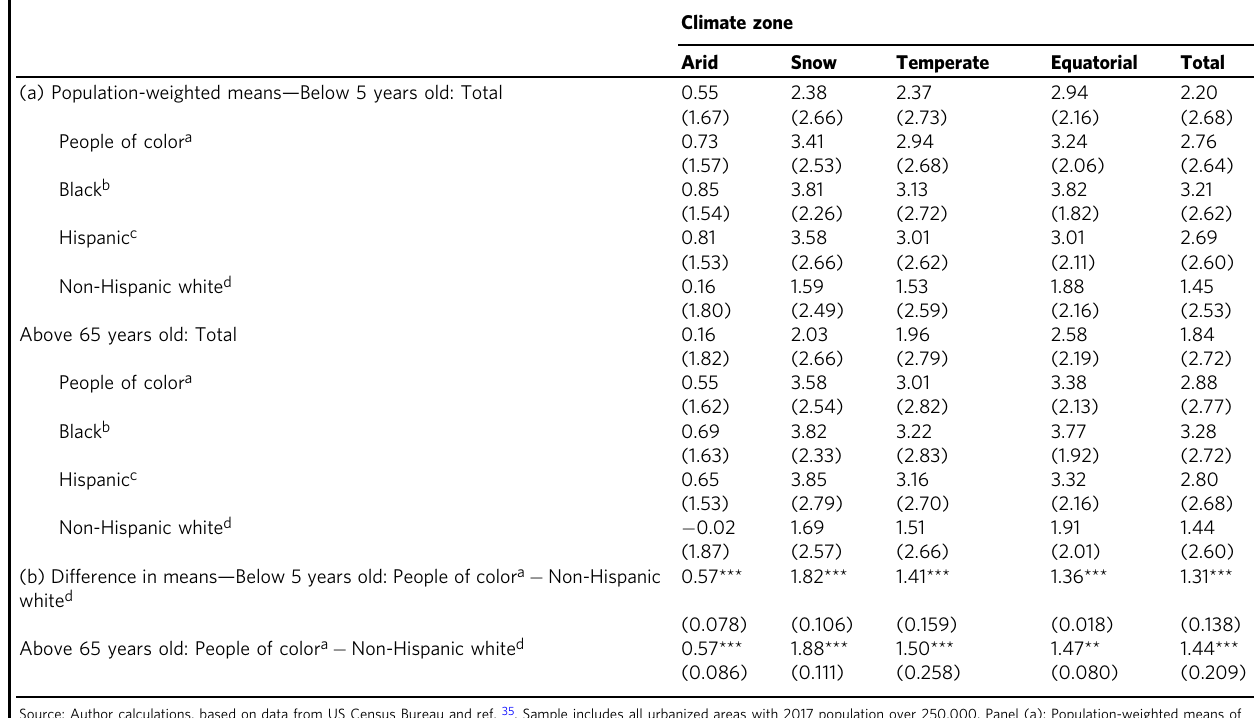
Table 3 Mean summer daytime surface urban heat island intensity (SUHI) by climate zone and age.